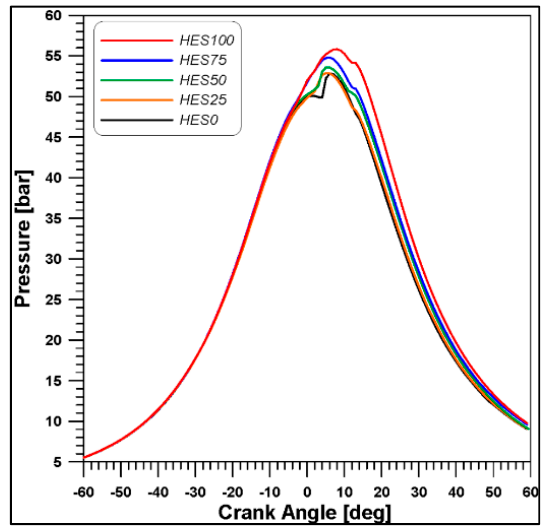
Figure 16. In-cylinder pressures.